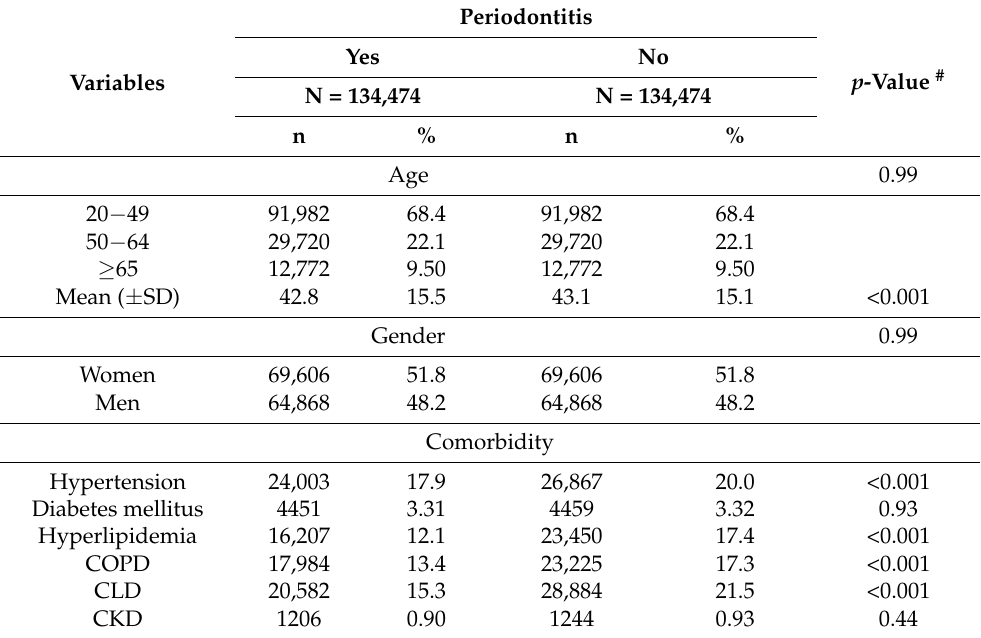
Table 1. Baseline characteristics for individuals with and without